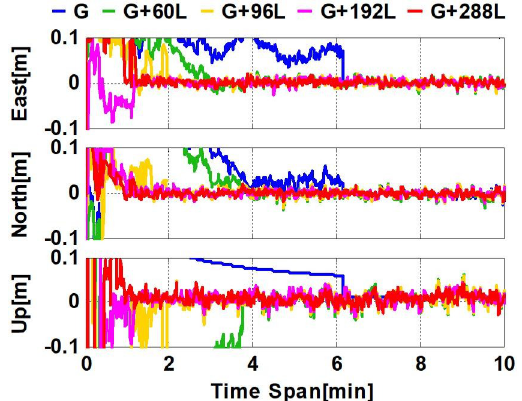
Figure 4. The local enlarged picture of the Figure 3 (dotted box) shows the first 10-min comparison of different scales of LEO constellations augmented GPS RTK solutions at three components, for ‘P339-P341′ baseline scheme. Table 5. Statistics of the baseline solution precisions after fixing ambiguity in three directions.